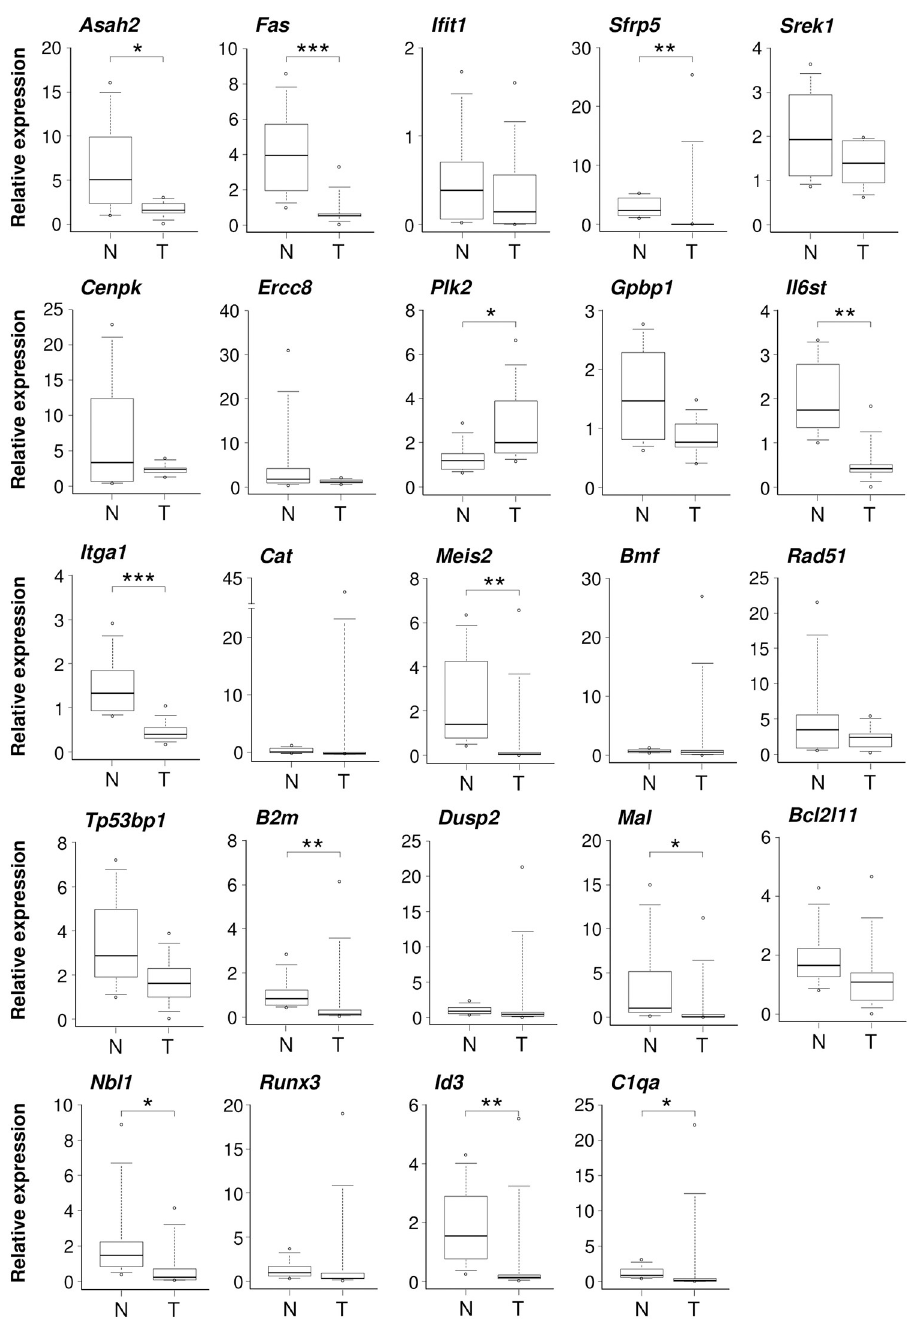
Fig 4. Expression of 24 genes located in chromosomes 1q52–54, 2q12–15, 3q31–42, and 5 showing copy-number losses in mammary carcinomas of irradiated (SD × COP)F 1 rats. Relative mRNA expression levels of the indicated genes in carcinomas and matched normal mammary glands are shown. N, normal tissues ( n = 7–8); T, tumors ( n = 10). Data are presented as box plots with median values indicated by horizontal bars within the boxes. Boxes represent values between the 25 th and 75 th percentiles, whiskers extend to the 5 th and 95 th percentiles, and circles represent outliers. � P < 0.05; �� P < 0.01, ��� P < 0.001 (Mann-Whitney U test). Relative expression was normalized to a specific